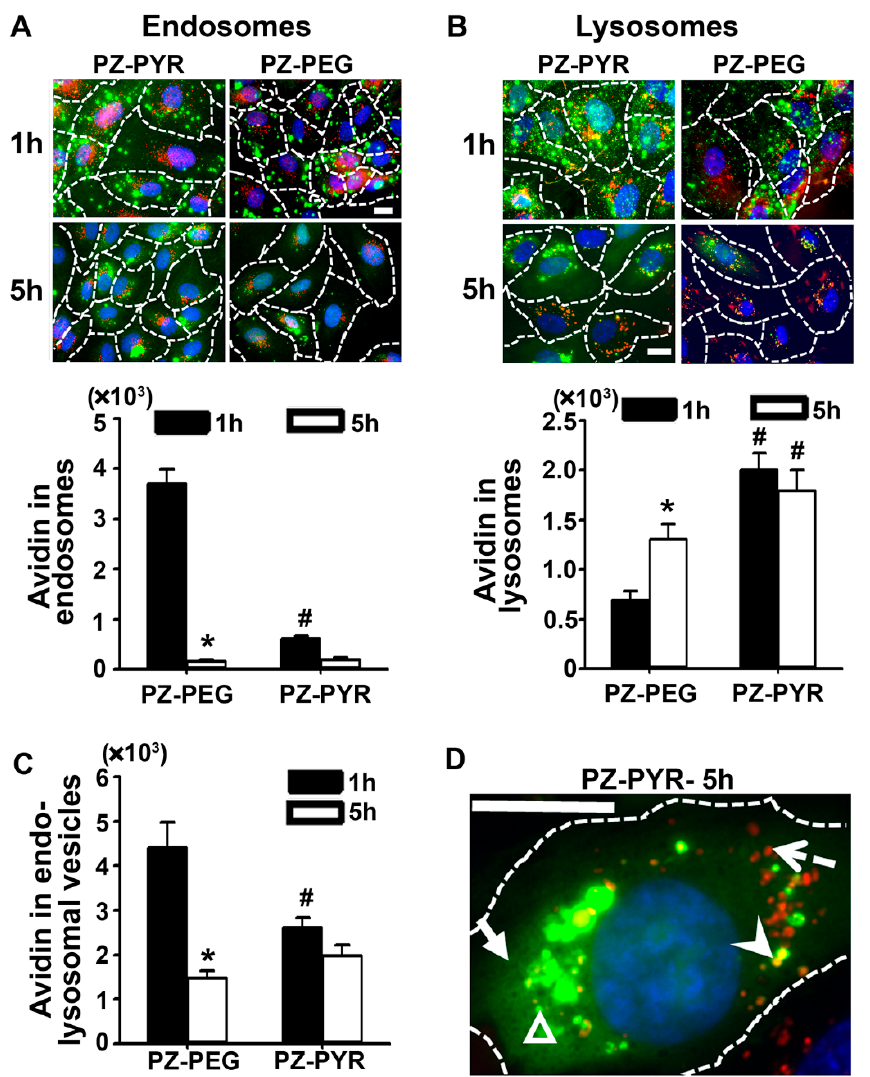
Figure 5. Subcellular trafficking of PZ/avidin complexes. HUVECs were incubated for 1 h at 37 ◦ C with FITC-avidin complexed to PZ-PYR or PZ-PEG and then processed for fluorescence microscopy or incubated for additional 4 h in complex-free cell medium (total 1 + 4 = 5 h) followed by sample processing. ( A ) Cells were permeabilized and early endosomes immunostained to appear red or ( B ) lysosomes were labeled by pre-incubating cells with 10 kDa Texas Red dextran prior to incubations with polymer/FITC-avidin complex. In both cases, colocalization of FITC-avidin with these compartments appears yellow (green + red) and is expressed as the area of pixels colocalizing with each compartment. ( C ) Total FITC-avidin in vesicular (endosomal + lysosomal) compartments, expressed as total area of colocalizing pixels. ( D ) High-magnification image of FITC-avidin delivered by PZ-PYR at 5 h, showing lysosomes which do not contain FITC-avidin (red; dotted arrow), FITC-avidin in lysosomes (yellow; arrowhead); FITC-avidin in dot-like vesicular compartments that are not lysosomes (green dots; open arrowhead), and FITC-avidin in the cytosol (solid arrow). All data are expressed as mean ± SEM. * p < 0.05 relative to 1 h. # p < 0.05 relative to PZ-PEG. Dashed lines = cell borders as seen by bright field. Scale bar = 10 µm.